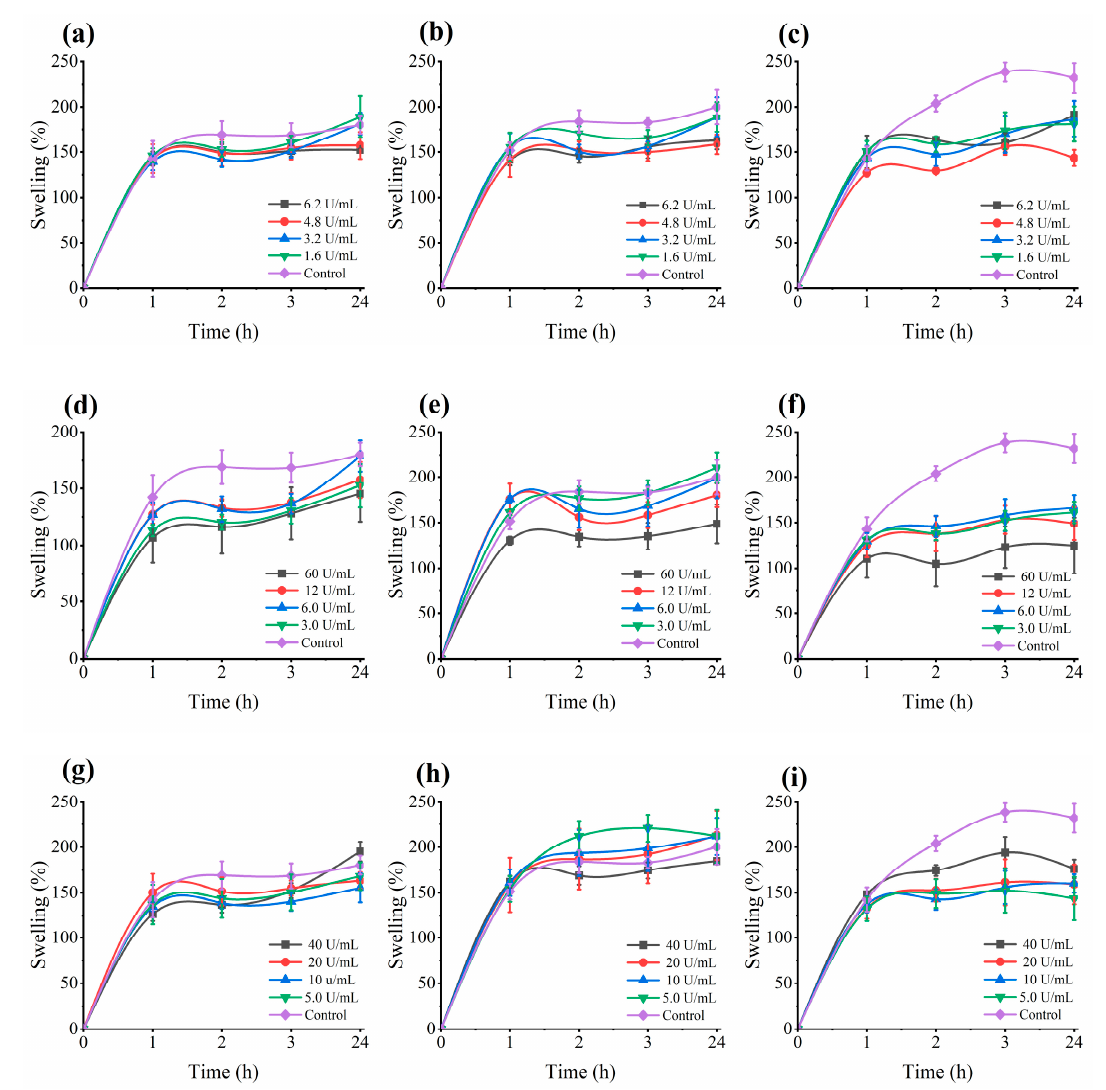
Figure 6. The influence of pH on the swelling ratio of BC obtained from analyses on cultivation media variant. The SR for BC obtained from the medium with sucrose and β -D-Fru at pH 4.0 ( a ), 5.0 ( b ) and 7.0 ( c ), lactose and β -Gal at pH 4.0 ( d ), 5.0 ( e ), and 7.0 ( f ); with starch and GLA at pH 4.0 ( g ), 5.0 ( h ), and 7.0 ( i ).